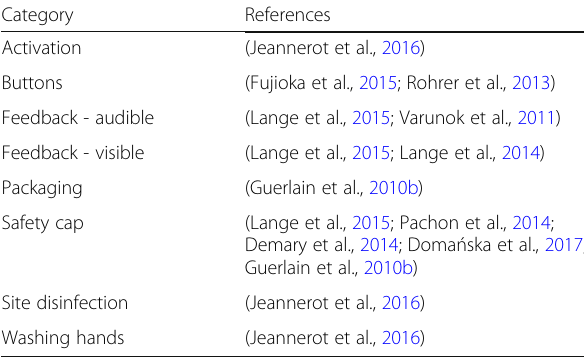
Table 2 Categories of reported operational